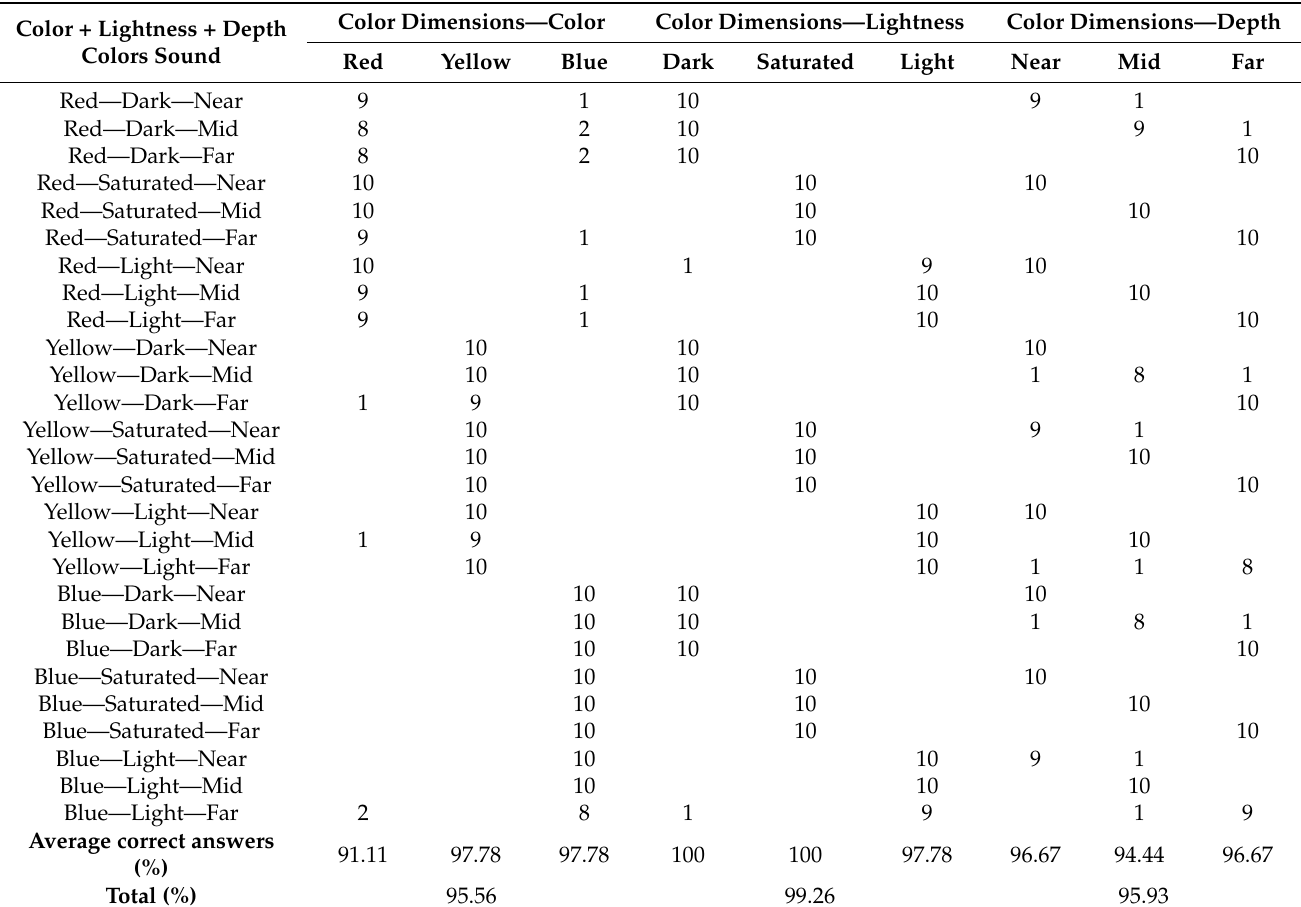
Table 10. Total color codes identification test in experiment 3 (color + lightness + depth).